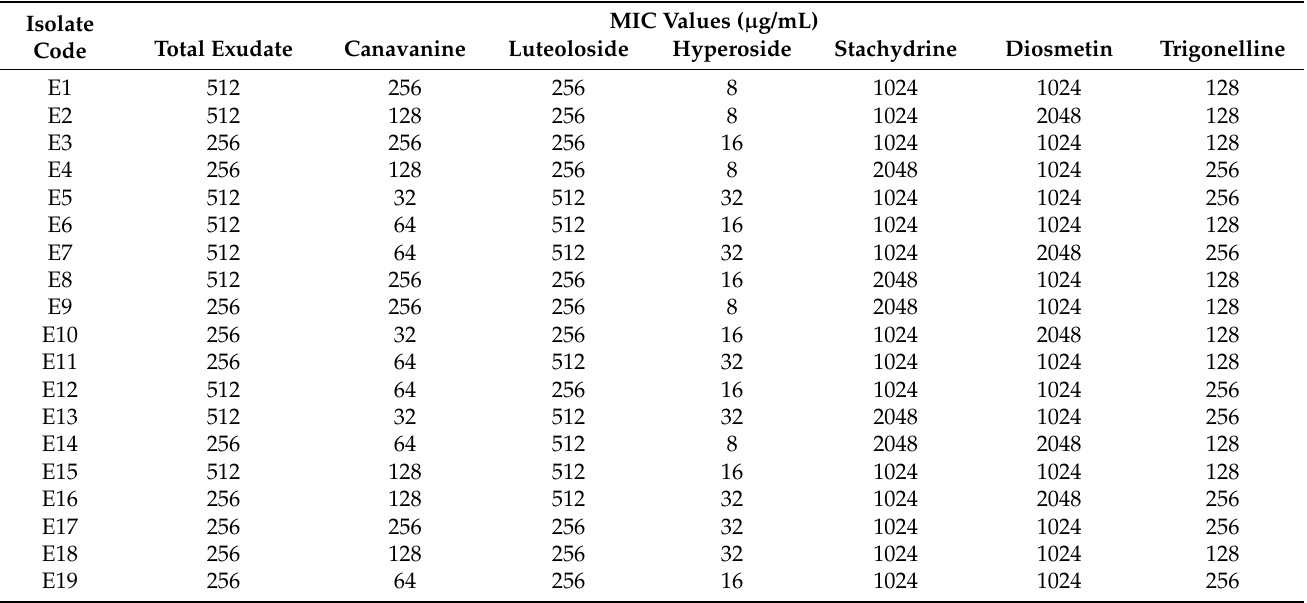
Table 3. Minimum inhibitory concentration values of the total extract and its isolated compounds.